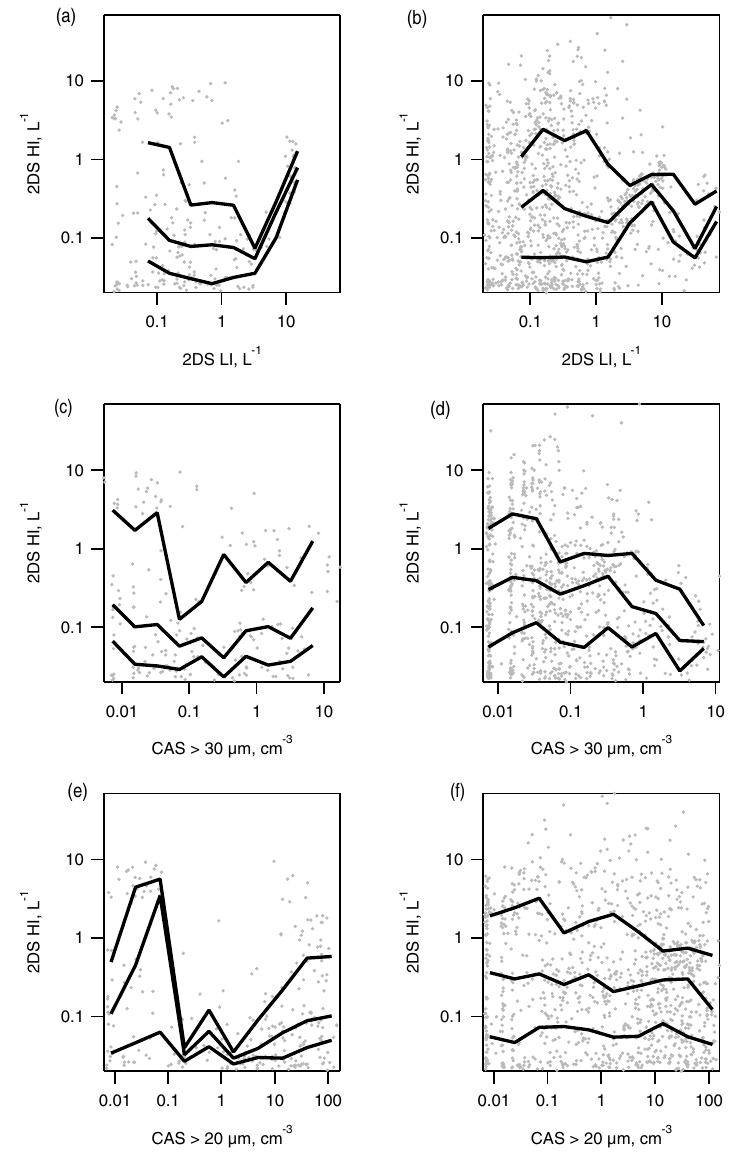
Figure 5. (a, b) The relationship between the concentration of highly irregular (2DS HI) particles and low irregular particles (2DS LI) (low irregular particles greater than approximately 80µm). Panels (c–f) show the relationship with the concentration of droplets larger than 30 and 20µm, respectively. Panels ( a ), ( c ) and ( e ) show measurements at temperatures lower than − 8 ◦ C and ( b ), ( d ) and ( f ) show those in the range − 8 to 0 ◦ C. The black lines are the 25th, 50th and 75th percentiles of the 2DS HI concentration for each droplet concentration